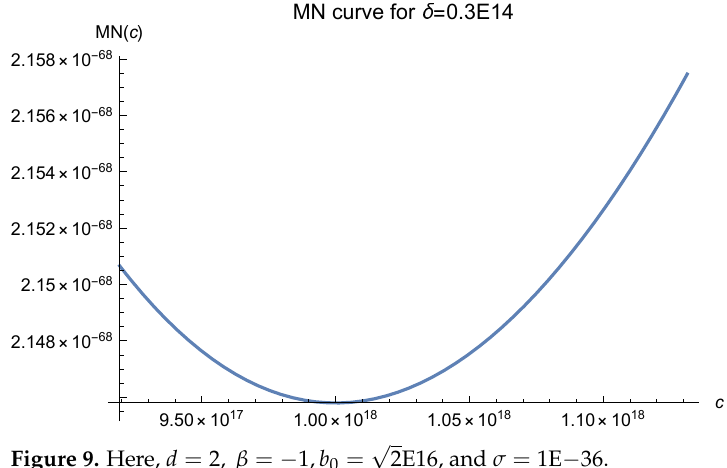
√ 2E16, and σ = 1E − 36. MN curve for = 0.3E14 (cid:1)